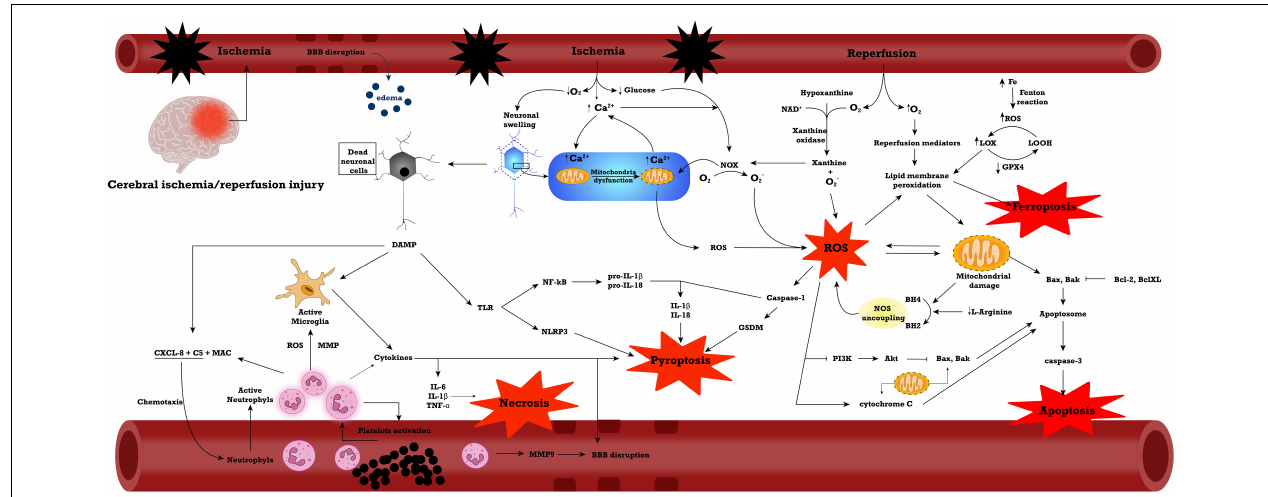
FIGURE 1 | General mechanisms in ischemia/reperfusion injury. Abbreviations: Akt, Protein kinase B; BBB, blood-brain barrier; C5, complement fraction 5; CXCL, C-X-C Motif Chemokine Ligand; DAMP, damage-associated molecular pattern; GPX4, glutathione peroxidase 4; IL, interleukin; LOOH, lipid alcohol; LOX, lipid peroxide; MAC, membrane attack complex; MMP, matrix metalloproteinase; NAD, nicotinamide adenine dinucleotide; NF-kB, nuclear factor kappa-light-chain-enhancer of activated B cells; NOS, nitric oxide synthase; NOX, NADPH oxidase; PI3K, phosphoinositide 3-kinases; ROS, reactive oxygen species; TLR, Toll-like receptor; TNF- α , tumoral necrosis factor α